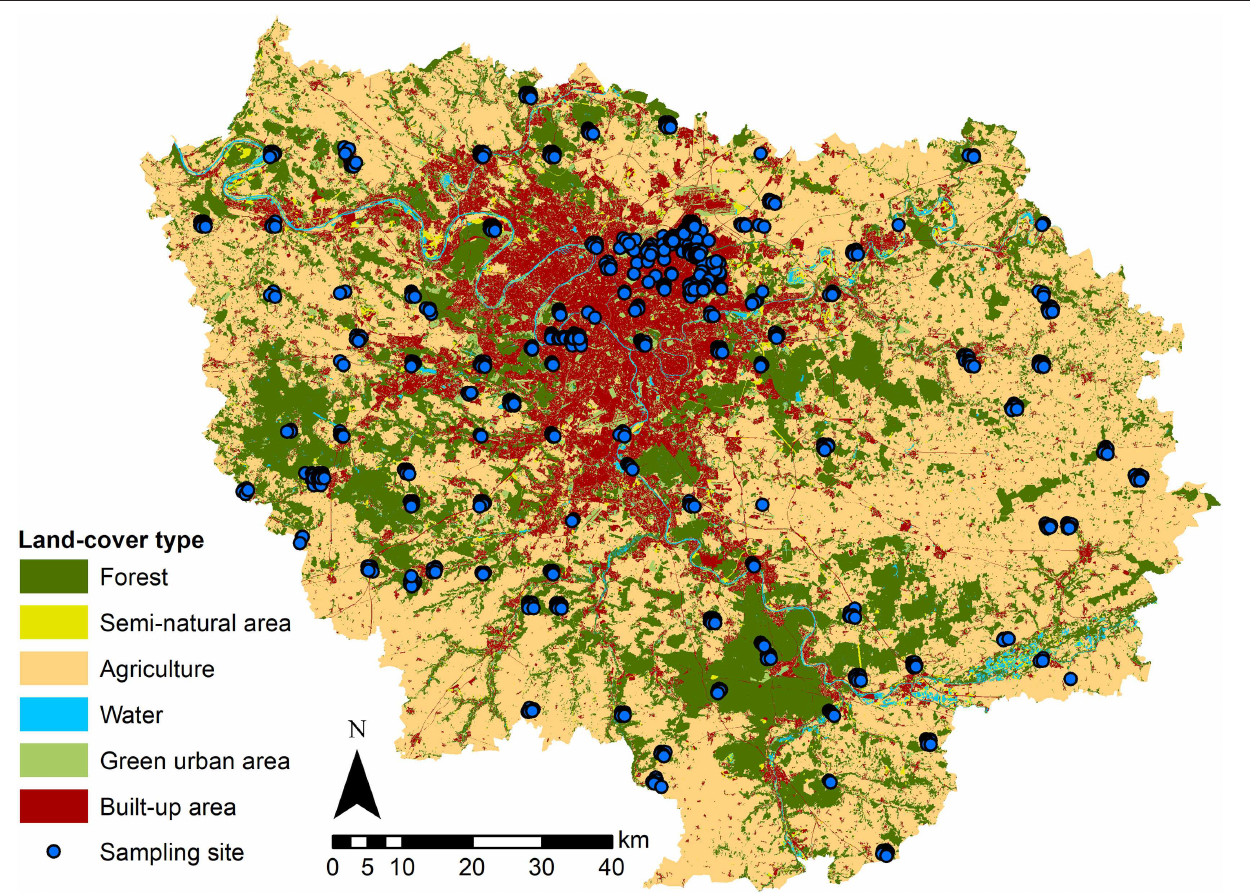
FIGURE 1 | Land cover and spatial distribution of the sampling plots (spatial resolution of 12.5 meters). The map shows the Île-de-France region, including its largest city Paris and ∼ 1,300 other cities and towns, which are represented by built-up areas [red, 16%, including individual housing (8%), collective housing (2%), industrial and business areas (2%), facilities (1%), quarries, dumps and worksites (0.5%) and transportation infrastructure (2.5%)]. The built-up areas and other land cover types that correspond to forests (dark green; 24% of total area), semi-natural areas (green yellow, 2%), agricultural areas (beige, 50%), green urban spaces (bright green, 6%) and rivers and water points (blue, 2%) were extracted from data from the Institut Paris Region (2018). The blue dots represent the 2,362 sampling plots of Vigie-flore from 2009 to 2017 (superimposed for the same plot surveyed in different